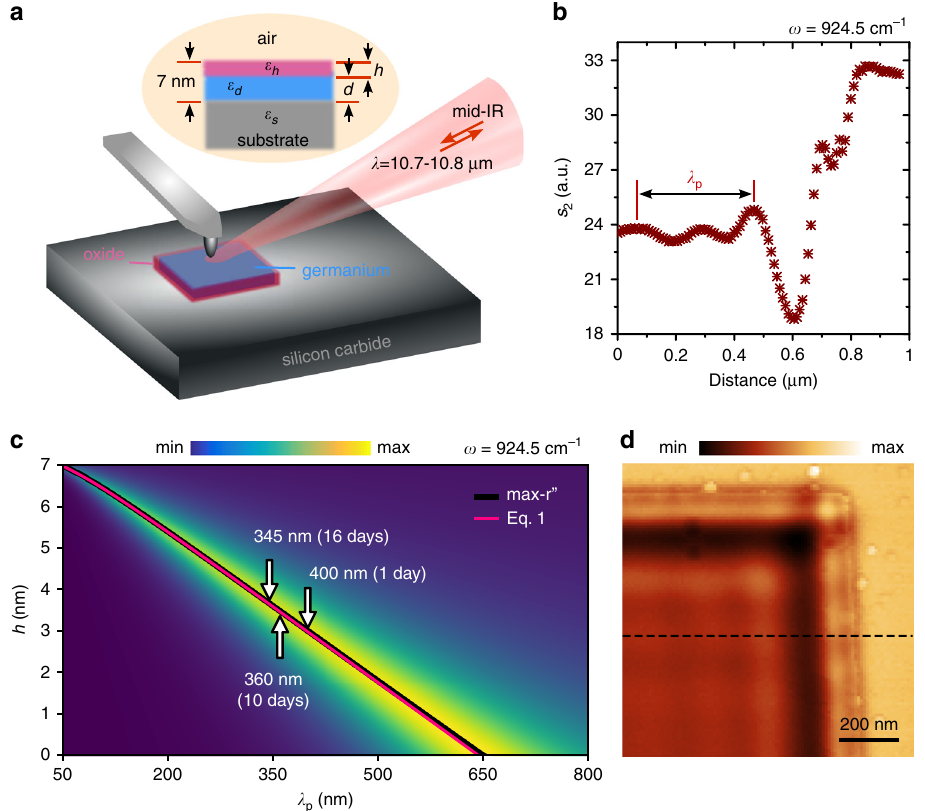
Fig. 1 Experimental and theoretical analysis of λ p scaling in the case of high con fi nement. a Sketch of the s-SNOM experiment. The inset on top shows schematics of the sample cross-section: a four-layer system consisting of bulk SiC substrate, nanometric germanium and oxide layers, and air. b Near- fi eld cross-section taken along black dashed line on image d . c Plot of the imaginary part of the interface re fl ection coef fi cient r 00 for p-polarization calculated at ω ¼ 924.5 cm − 1 . Black (max- r 00 ) and pink (based on Eq. (1)) curves depict λ scaling versus oxide thickness. d Near- fi eld image (optical amplitude s 2 ) p recorded at the corner of 7-nm-thick large (10 × 10 μ m) germanium microstructure at ω ¼ 924.5 cm − 1 (cid:1) (cid:3) j oxide layers, respectively. The calculated λ h ð Þ ¼ 2 π = j Re k p p solution of Eq. (1) (at ω ¼ 924.5 cm − 1 for T ¼ 7 nm) is plotted with pink curve in Fig. 1c, which closely merges with max- r 00 at shorter SPhP wavelengths as expected from the asymptotic. The derived relation would allow direct analysis of the scaling and the dispersion of highly con fi ned SPhPs in nanometric composite fi lms, providing a link between the interface composition change and the polariton wavelength.